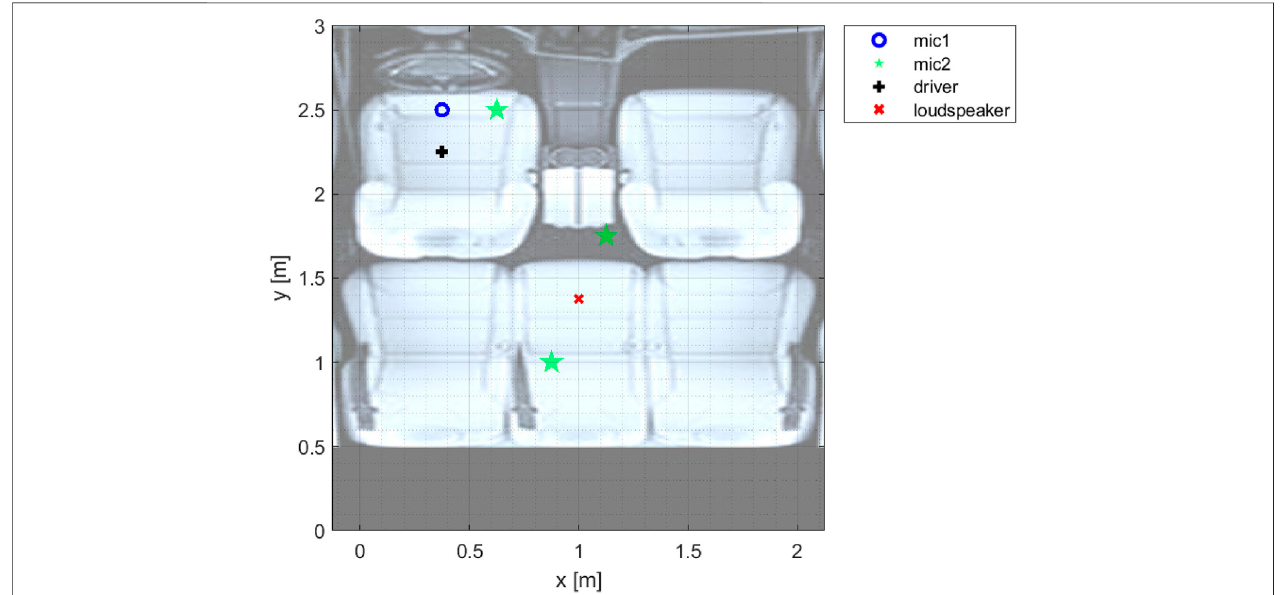
FIGURE 10 | An illustration of the car-cabin room con fi guration, in the XY axes.